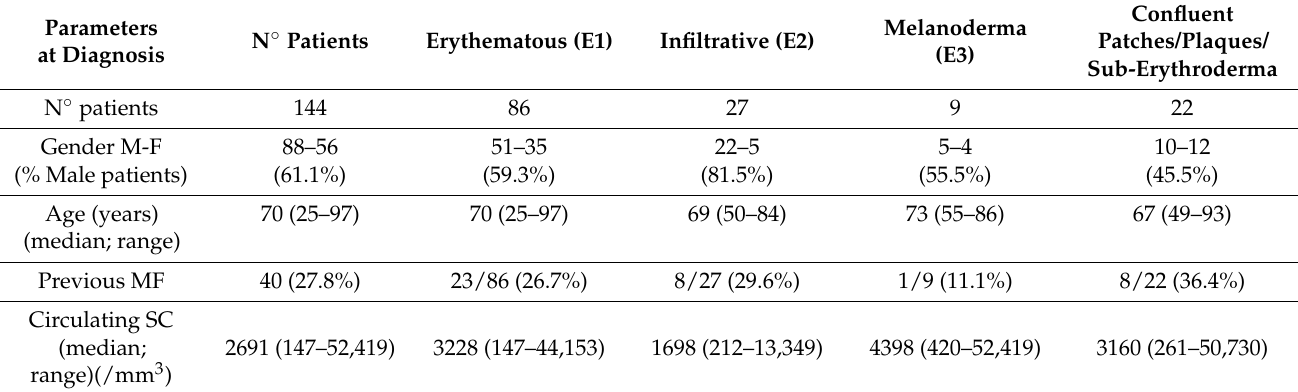
Table 1. Patients’ characteristics at diagnosis.